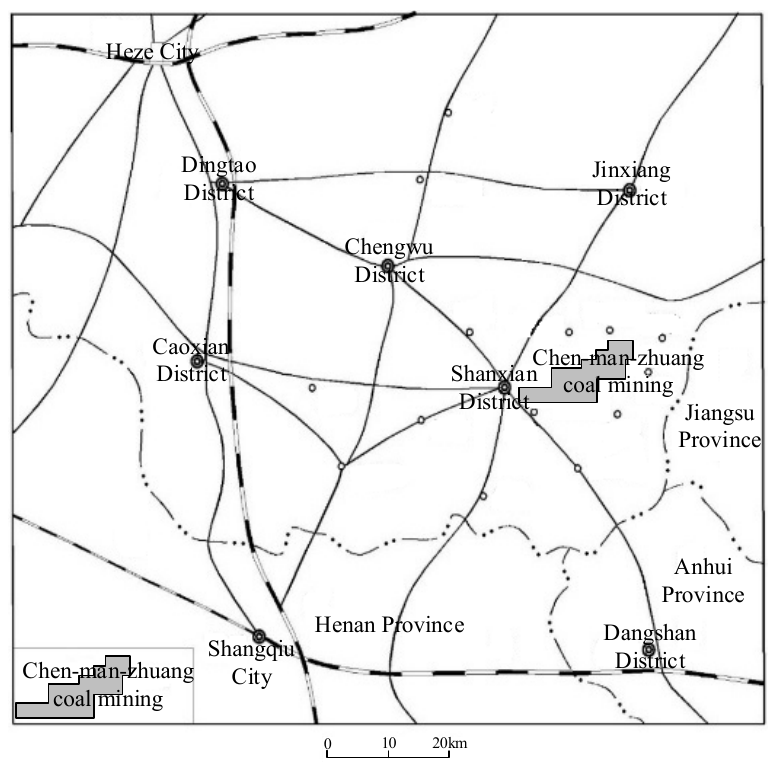
Figure 1. Schematic diagram of geographical location of Chen-man-zhuang project.